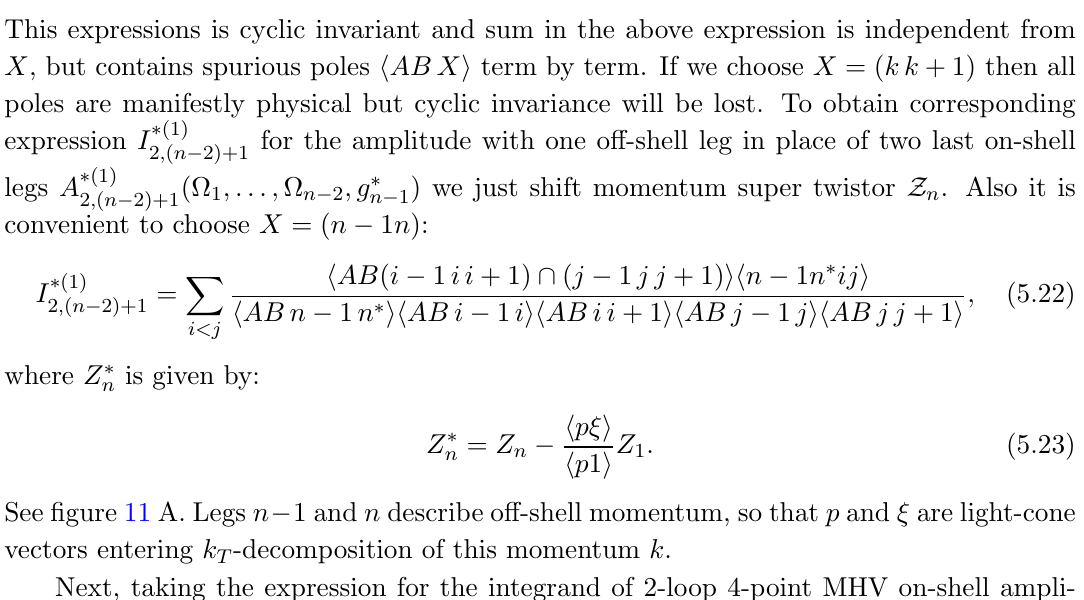
Figure 11 . Integrals for A ∗ (1) (Ω 1 , . . . , Ω n − 2 , g ∗ ) and A ∗ (2) (Ω 1 , Ω 2 , g ∗ ). Green lines cor- n − 1 3 2 , 2+1 2 , ( n − 2)+1 responds to eikonal propagators with shifted twistor. Wavy line corresponds to numerator of the form AB ( ij ) W , where ( ij ) W = ( i 1 i i + 1) ( j 1 j j + h i − ∩ −